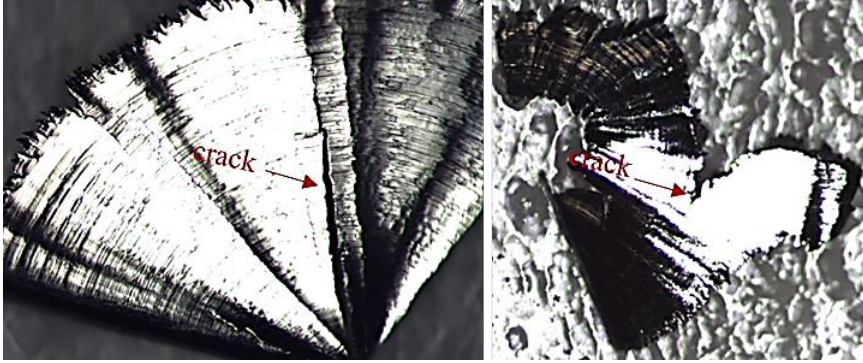
Figure 15. Cracks observed on the additively manufactured nickel alloy Inconel 625 chips.